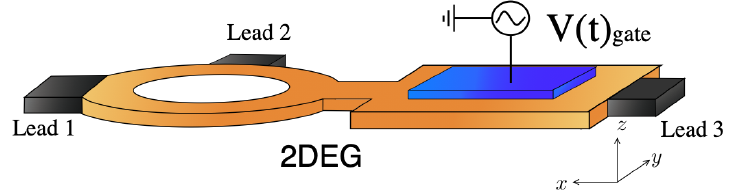
Figure 6: Setup of the dynamical spin-orbit based spin transistor with the top terminal (Lead 2) controlled electrostatically. The AC gate voltage in the right cavity induces a dynamical Rashba SOI, which creates an AC spin current that flows into the ring on the left. There, due to a spatially inhomogeneous Rashba SOI, the spin current is transformed into a nonzero charge current if the number of leads attached to the ring is greater than 2; the charge current is strongly suppressed in the two-terminal